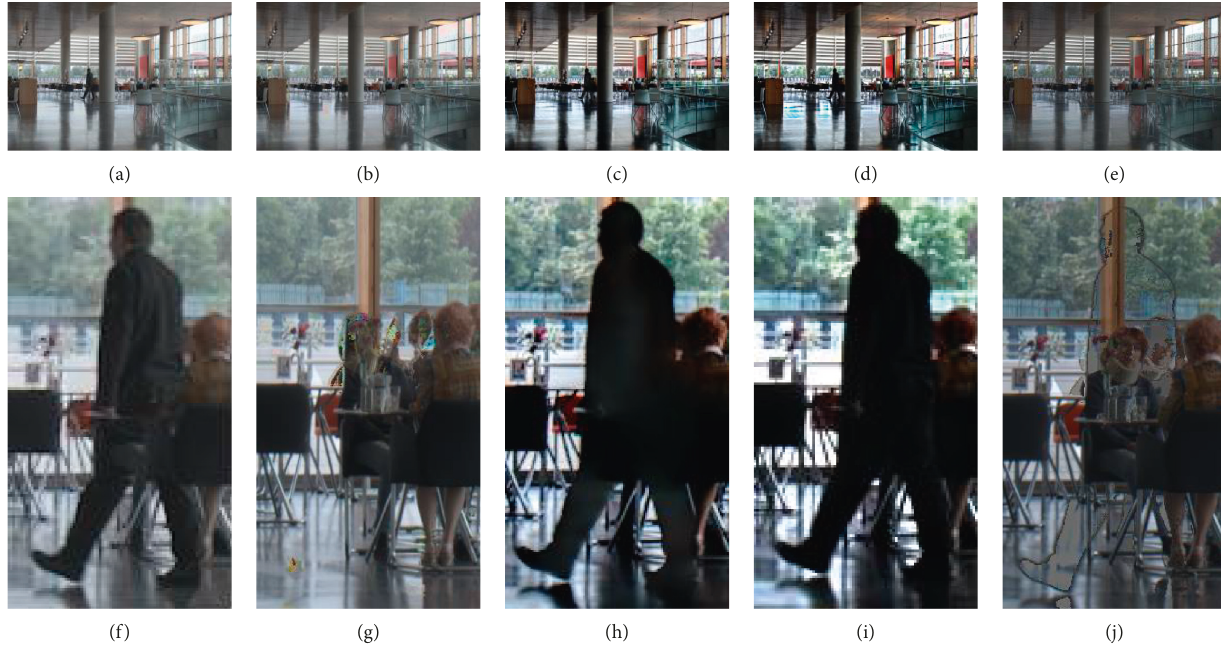
Figure 3: Comparison results on “Cafe” with (a) the proposed method; (b) Oh et al. [26]; (c) Hu et al. [18]; (d) Ma et al. [32]; (e) Photoshop cs6; (f–j) corresponding closeups of